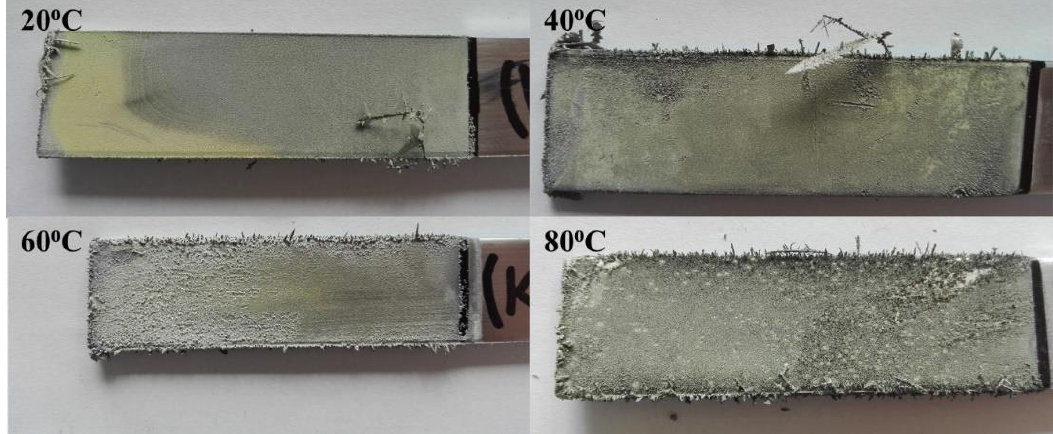
Figure 4. Photos of lead electrodeposited from triethylenetetramine solution at different temperatures .